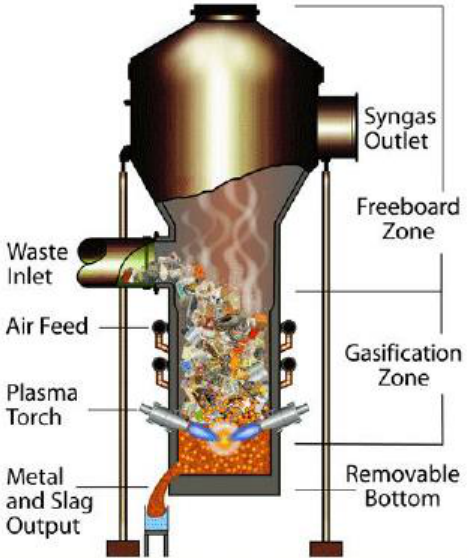
Figure 5. Plasma gasification model